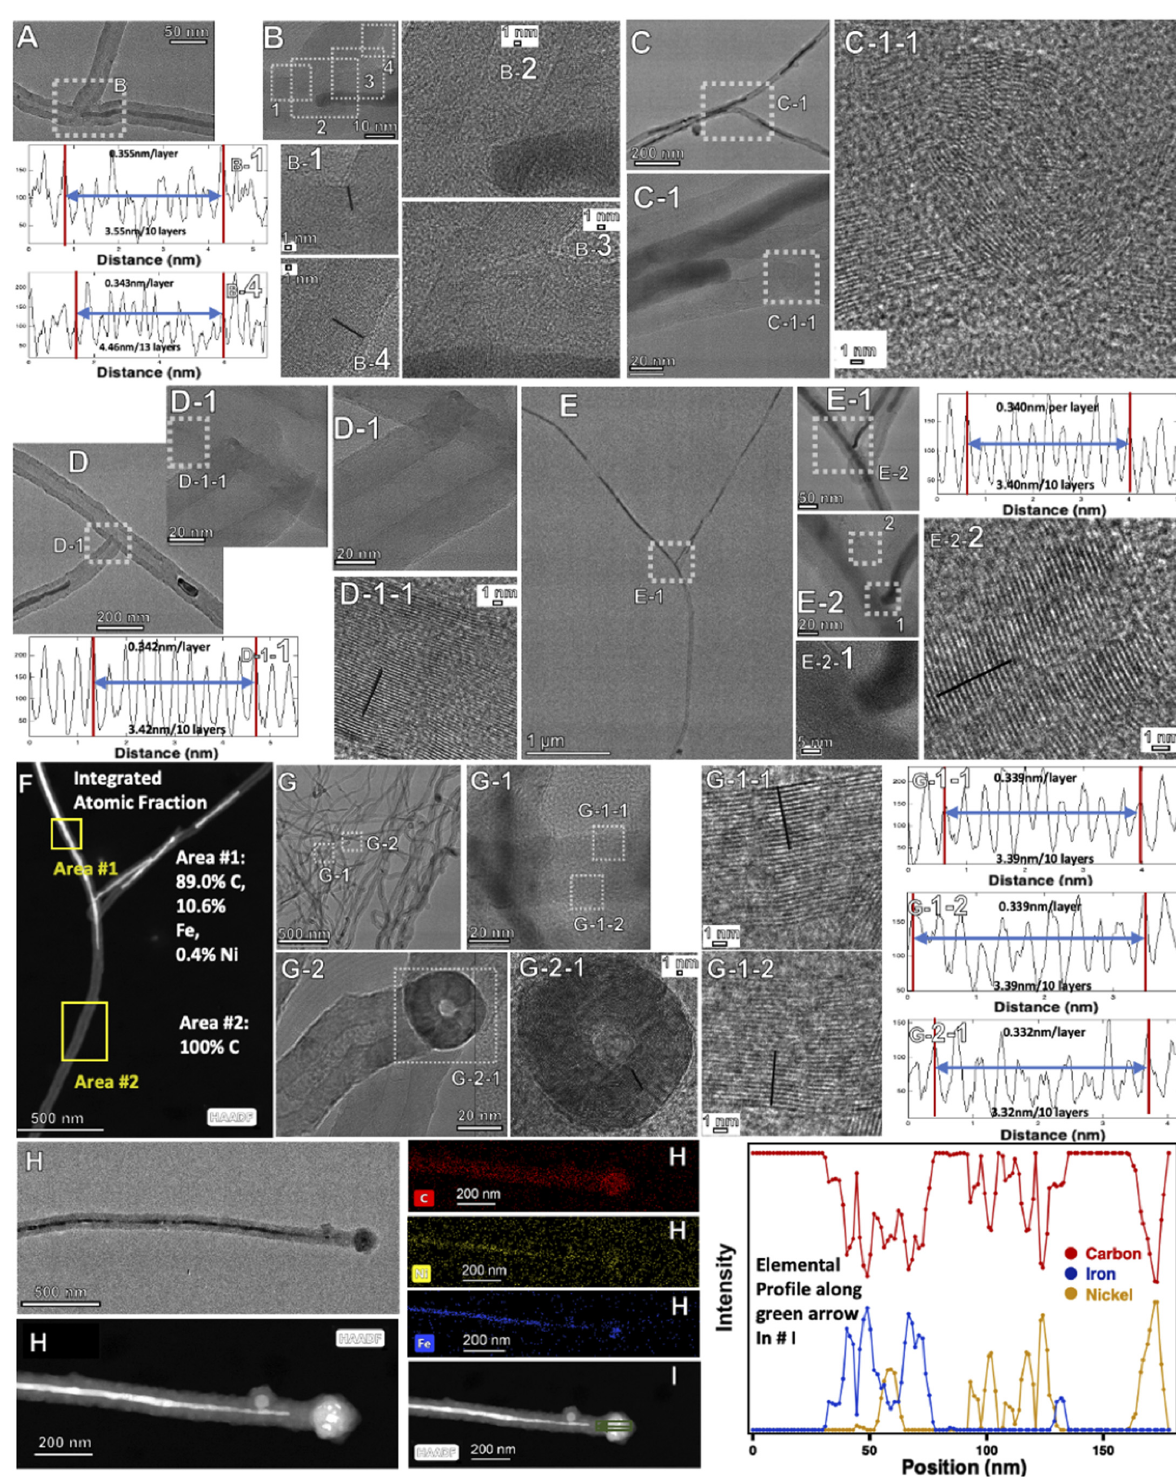
Figure 9. TEM and HAADF elemental analysis of the nano-dragons carbon allotrope synthesized by molten carbonate electrolysis. ( A , C , D ): Nano-dragon; ( B ) and B-1: Nano-dragon wall and meas- ured graphene layer thickness ( E ); Nano-drageon and (right side) elemental analysis.